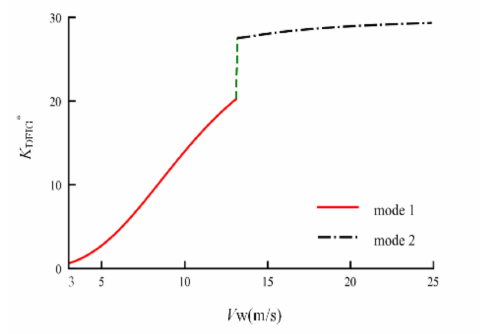
Figure 4. K DFIG * with di ff erent wind speeds, the solid line for the fixed pitch angle mode (Mode 1), the dashed line for the fixed rotor speed mode (Mode